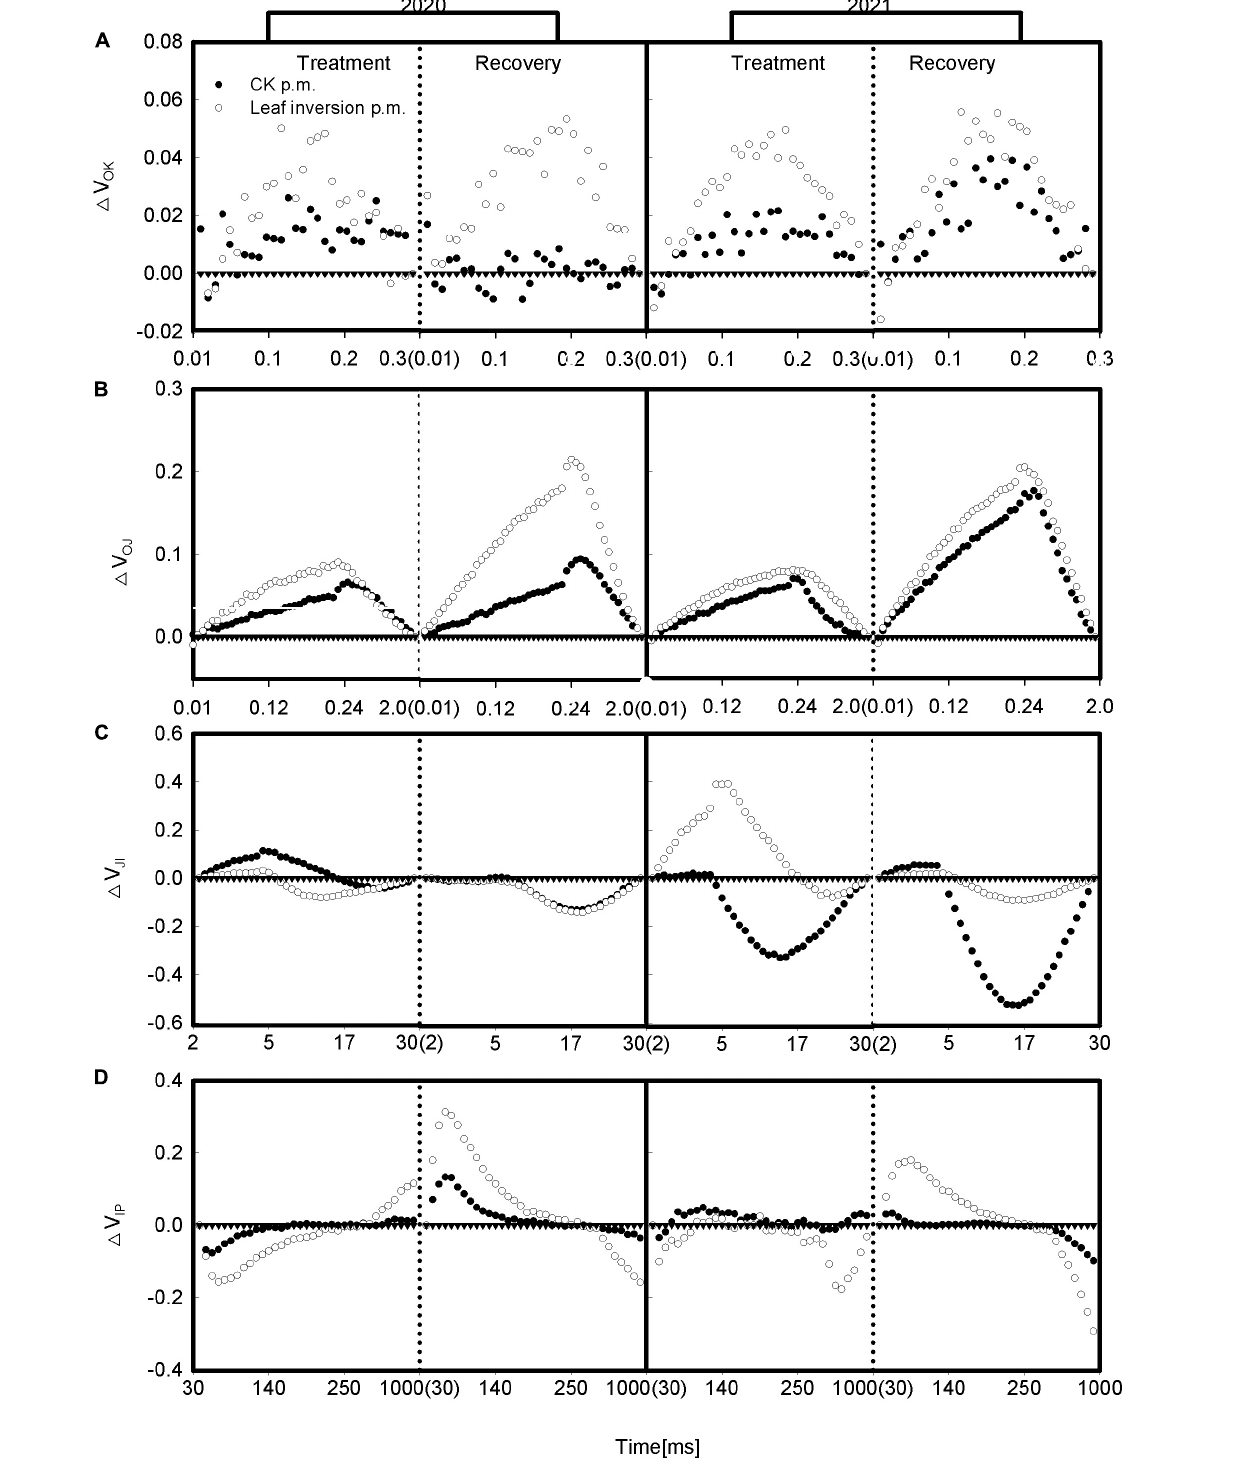
Frontiers in Plant Science |